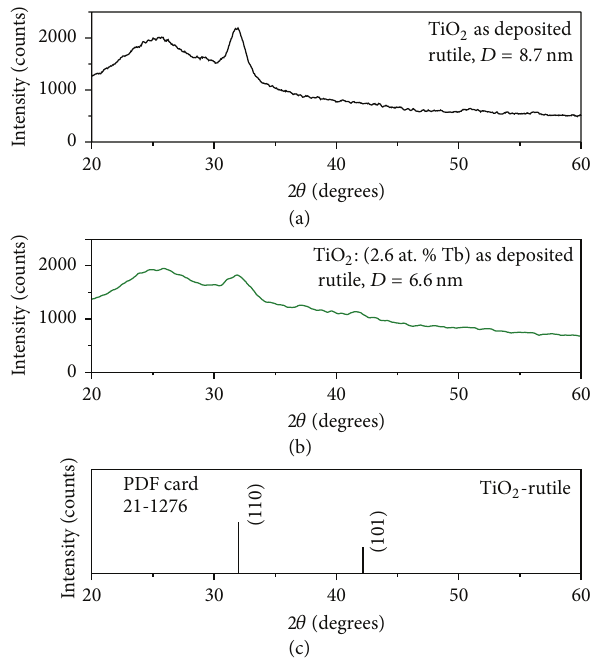
Figure 1: XRD measurements results of (a) undoped TiO 2 thin film, (b) TiO 2 :Tb thin film, and (c) standard patterns for TiO 2 -rutile structure. 𝐷 : crystallite